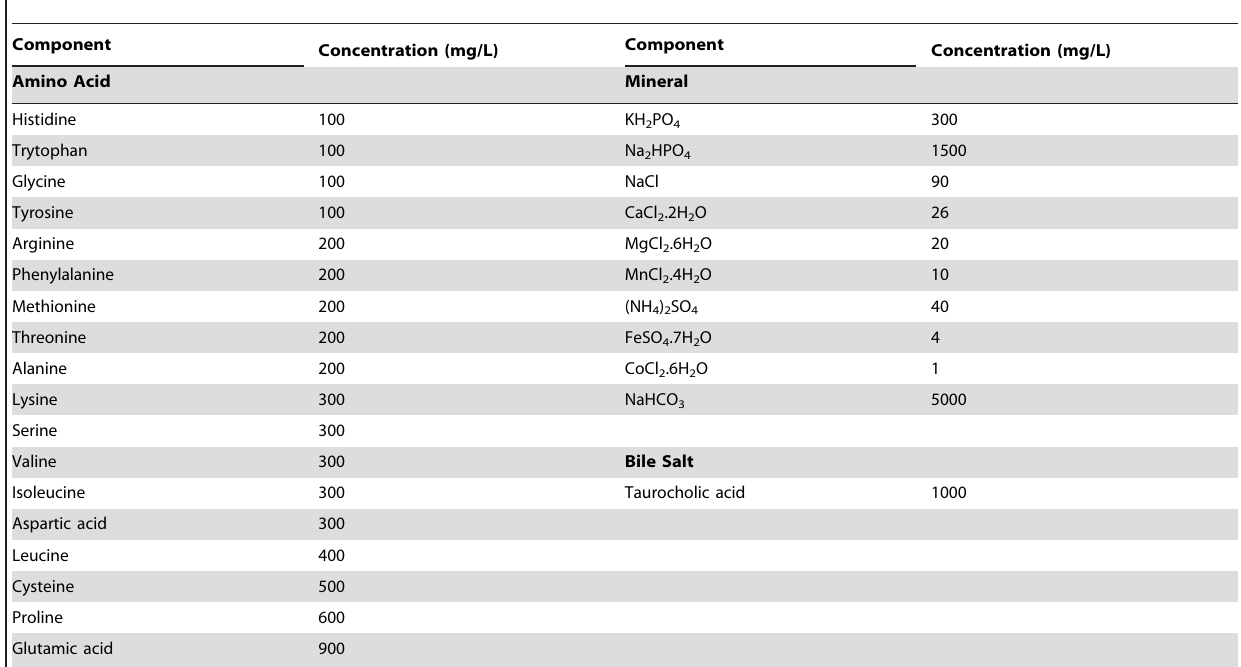
Table 1. Formulation of Clostridium difficile spore germination solution consisting of amino acids, minerals and taurocholic acid prepared in sterile deionized